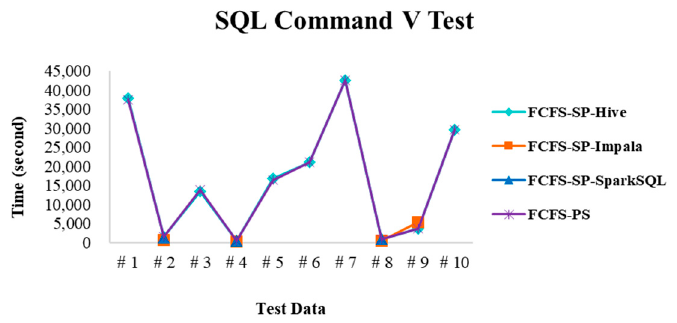
Figure 19. Execution time of SQL command V in test environment I.